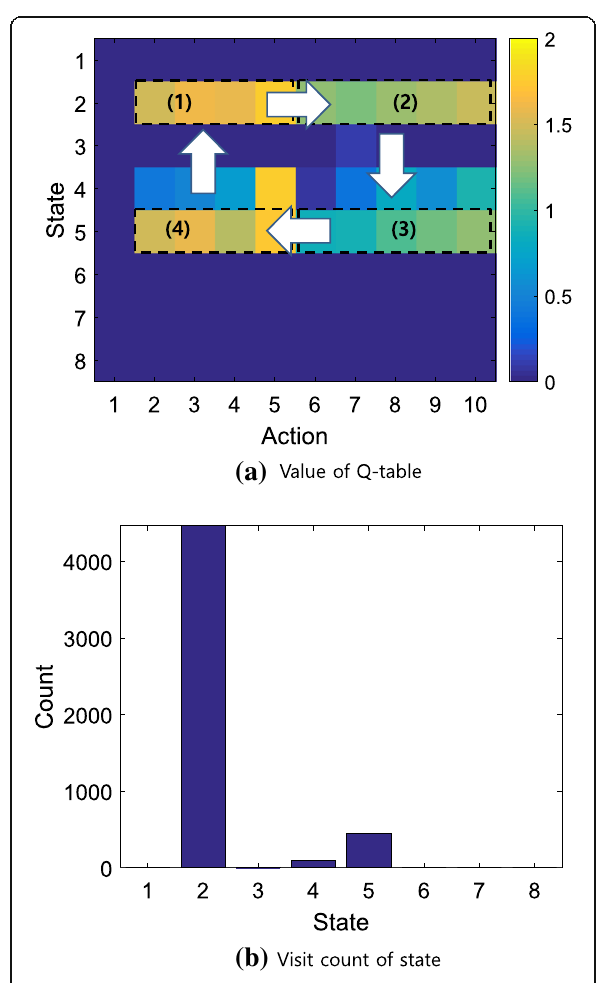
Fig. 11 The a Q-value of Q-table when DDR=40kbps, and b number of state visits. Similar to Figs. 9 and 10a, the Q-value of Q-table shows the channel movement of low DDR case. The visit count of state is high in the state of low DRE and low CBG because the stable domain is in that